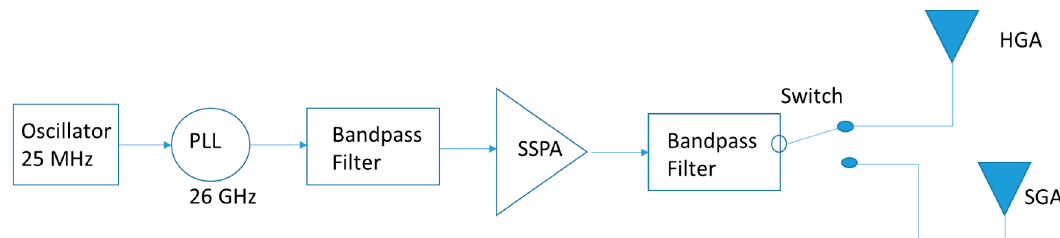
Figure 9. ISARA Block diagram.